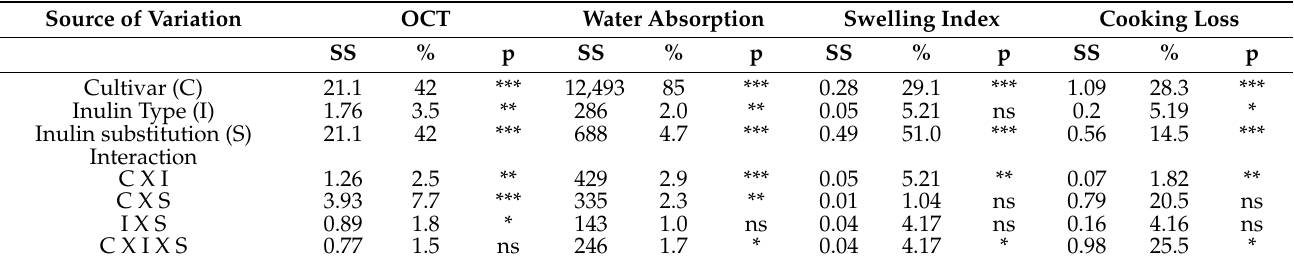
Table 4. Sum of square (SS) and percentage of variation (%) of spaghetti samples cooking quality in relation to the studied factors.